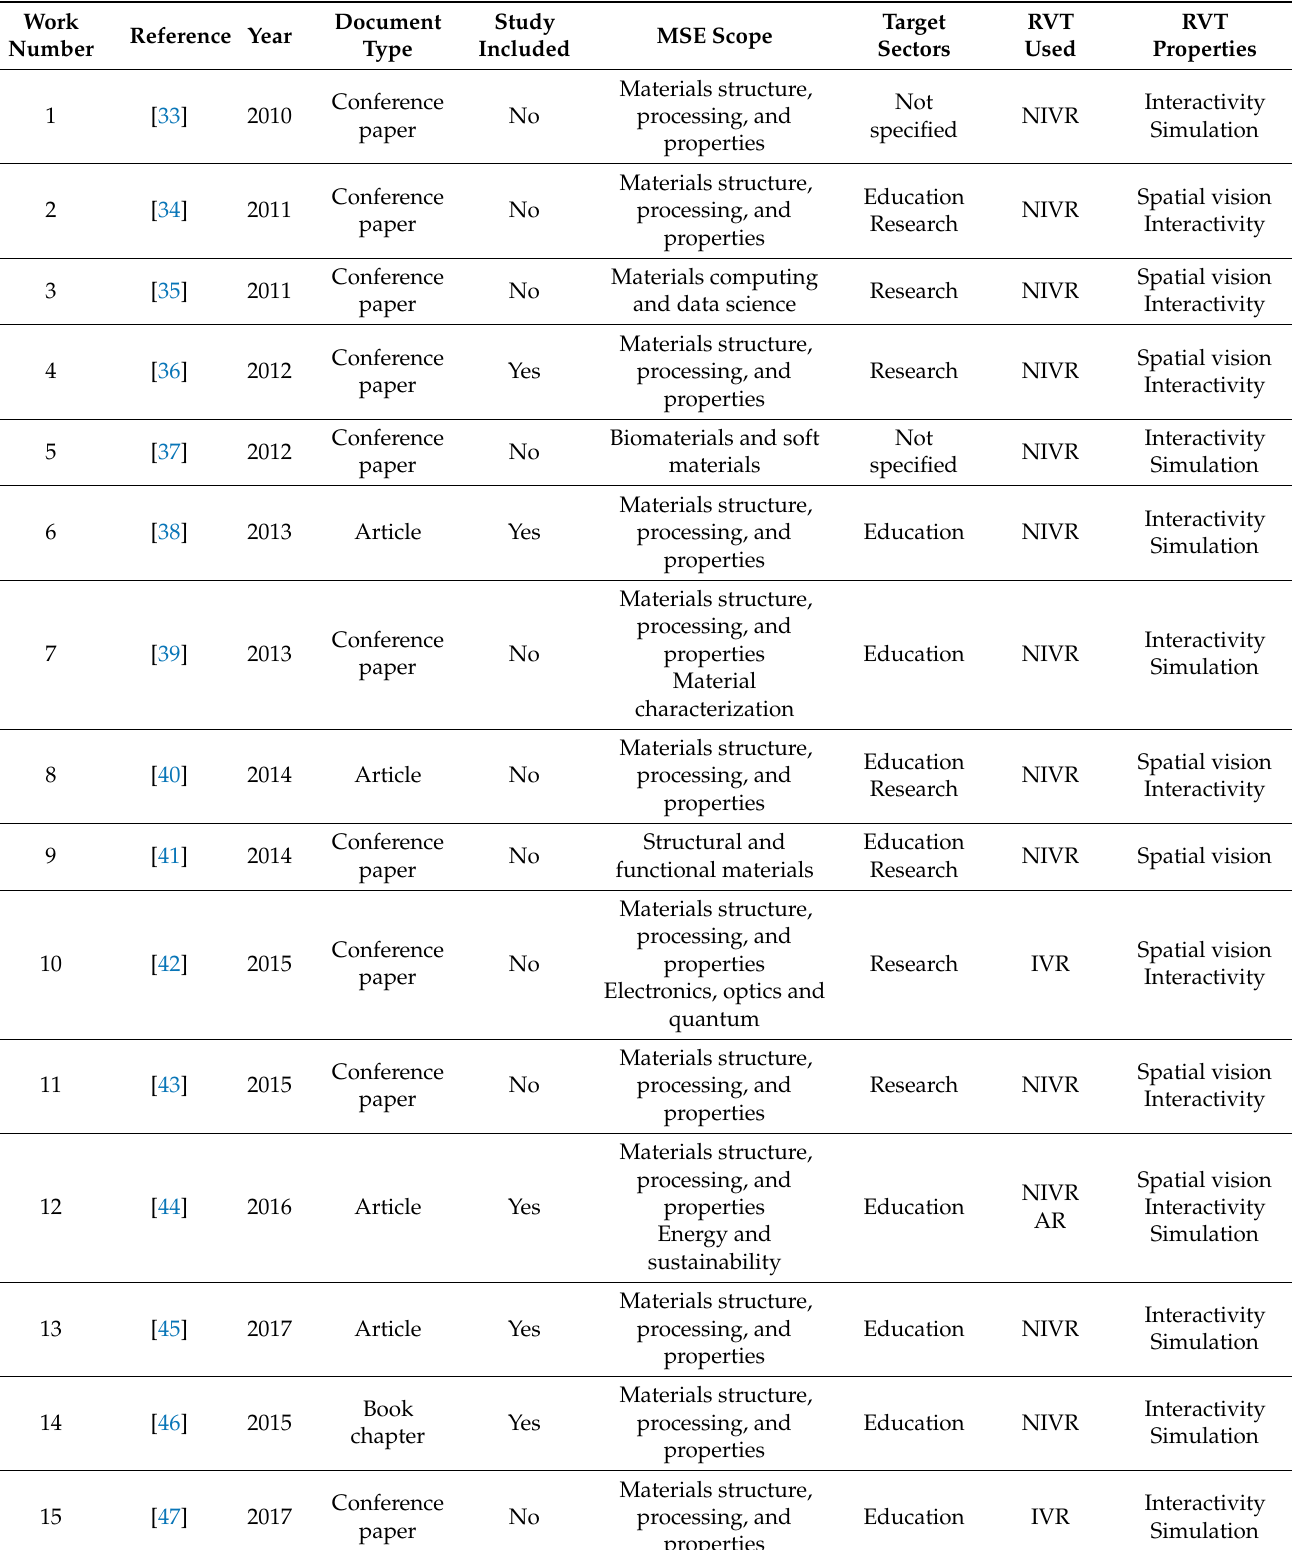
Table 4. Summary of the features of the 41 analyzed works. Note that the following